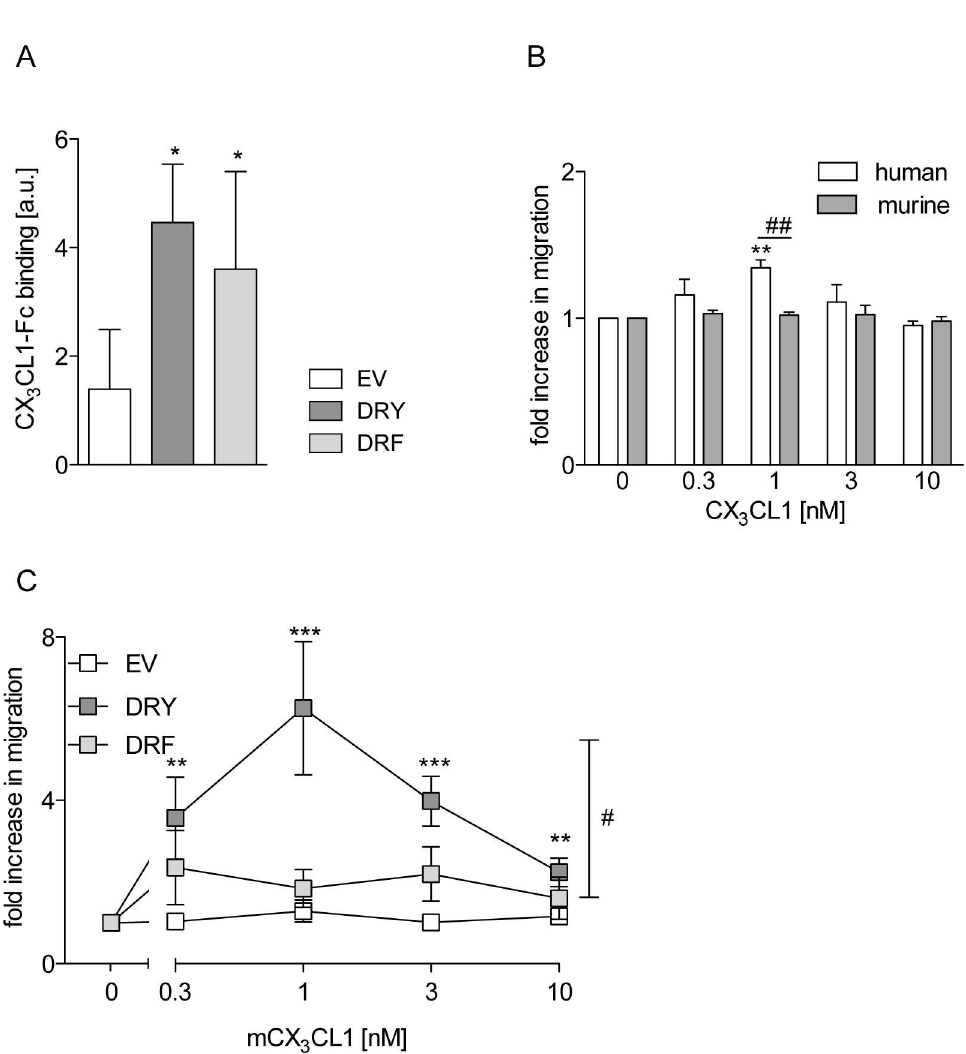
Fig 6. The DRF motif impairs chemotaxis. THP-1 cells were transduced with lentivirusencoding murine CX 3 CR1 variants or EV control. A: Ligandbindingwas analyzedby incubationwith humanCX 3 CL1-Fc fusion proteinand FACS analysis(n = 3). B/C: Chemotaxis againstincreasingconcentrations of solubleCX 3 CL1 was analyzedin a Boydenchamberassay. In B, wild type cells were investigated for chemotaxis towardssoluble murine or humanCX 3 CL1 (n = 3), and in C cells overexpressing murinereceptorvariants were assayedfor chemotaxistowardsmurineCX 3 CL1 (n (cid:21) 3). Statistical differences were analyzedby one-samplet-test (B, hypothetical value1) or Student’st-test (A-C). Asterisks indicatedifferencesto control (EV in A, random migration in B/C), hashesindicatedifferences betweenreceptorvariants ( * /#p < 0.05, ** /##p < 0.01, *** p <